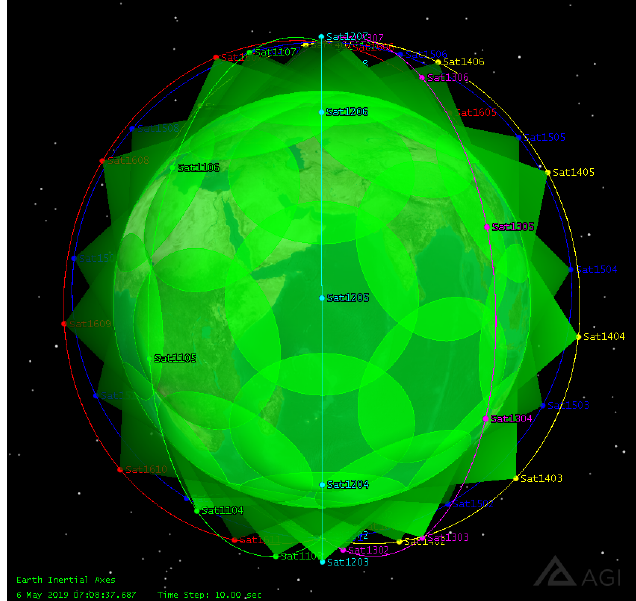
Figure 7. The coverage characteristics of the entire satellite IoT sensor. Table 2. Cumulative coverage and latitudes coverage.